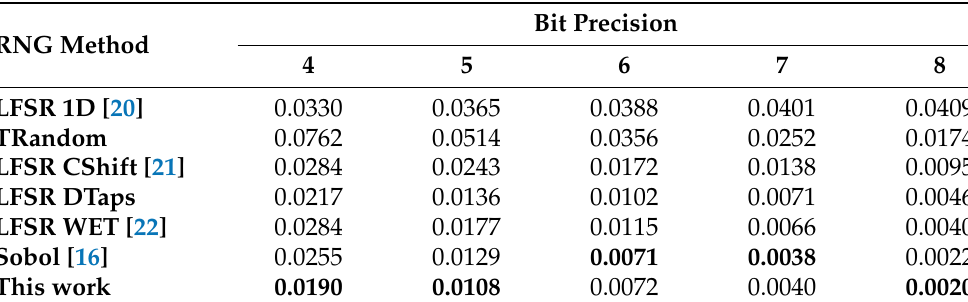
Table 5. MAE for different RNG circuits evaluated for different bit-precision in the multiplication operation. The best result of each column is highlighted in bold.